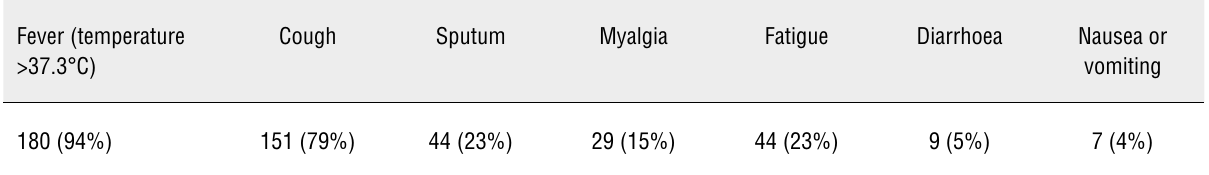
Table 1- Summary of the symptoms recorded in 191 COVID-19 confirmed patients hospitalized in Jinyintan Hospital or Wuhan Pulmonary Hospital before January 31st, 2020 (45). (n=